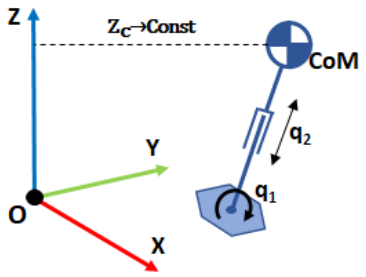
Figure 3. The Three-Dimensional Linear Inverted Pendulum Model (3DLIPM).